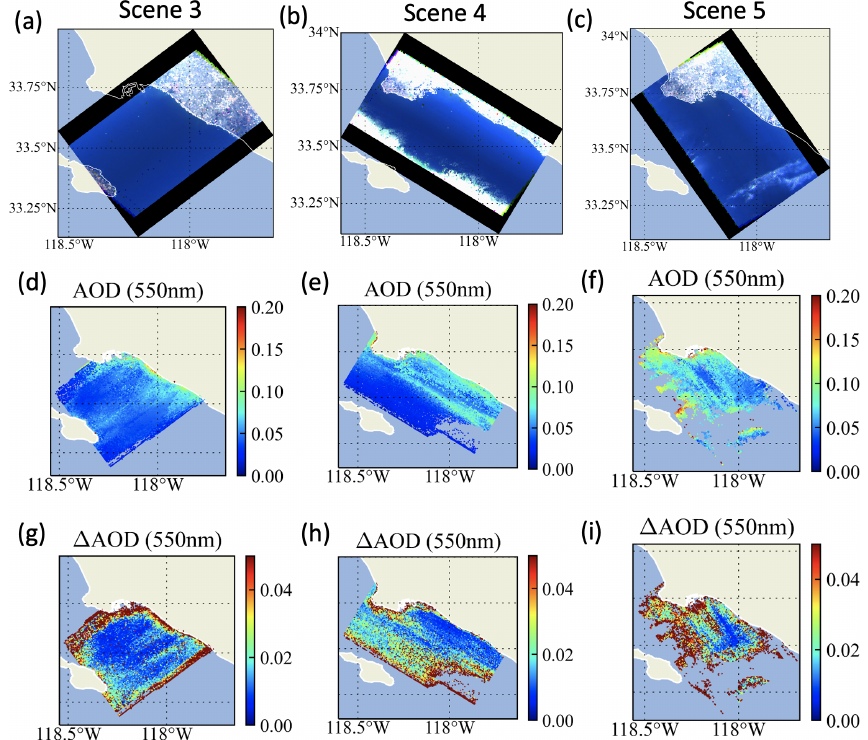
Figure 12. Three AirHARP scenes on 23 October, 27 October, and 7 November 2017, which are in different flight directions but over the same region. The RBG images are shown in panels (a) , (b) , and (c) ; the retrieved AODs at 550nm are shown in panels (d) , (e) , and (f) ; and their uncertainties are shown in panels (g) , (h) , and (i)